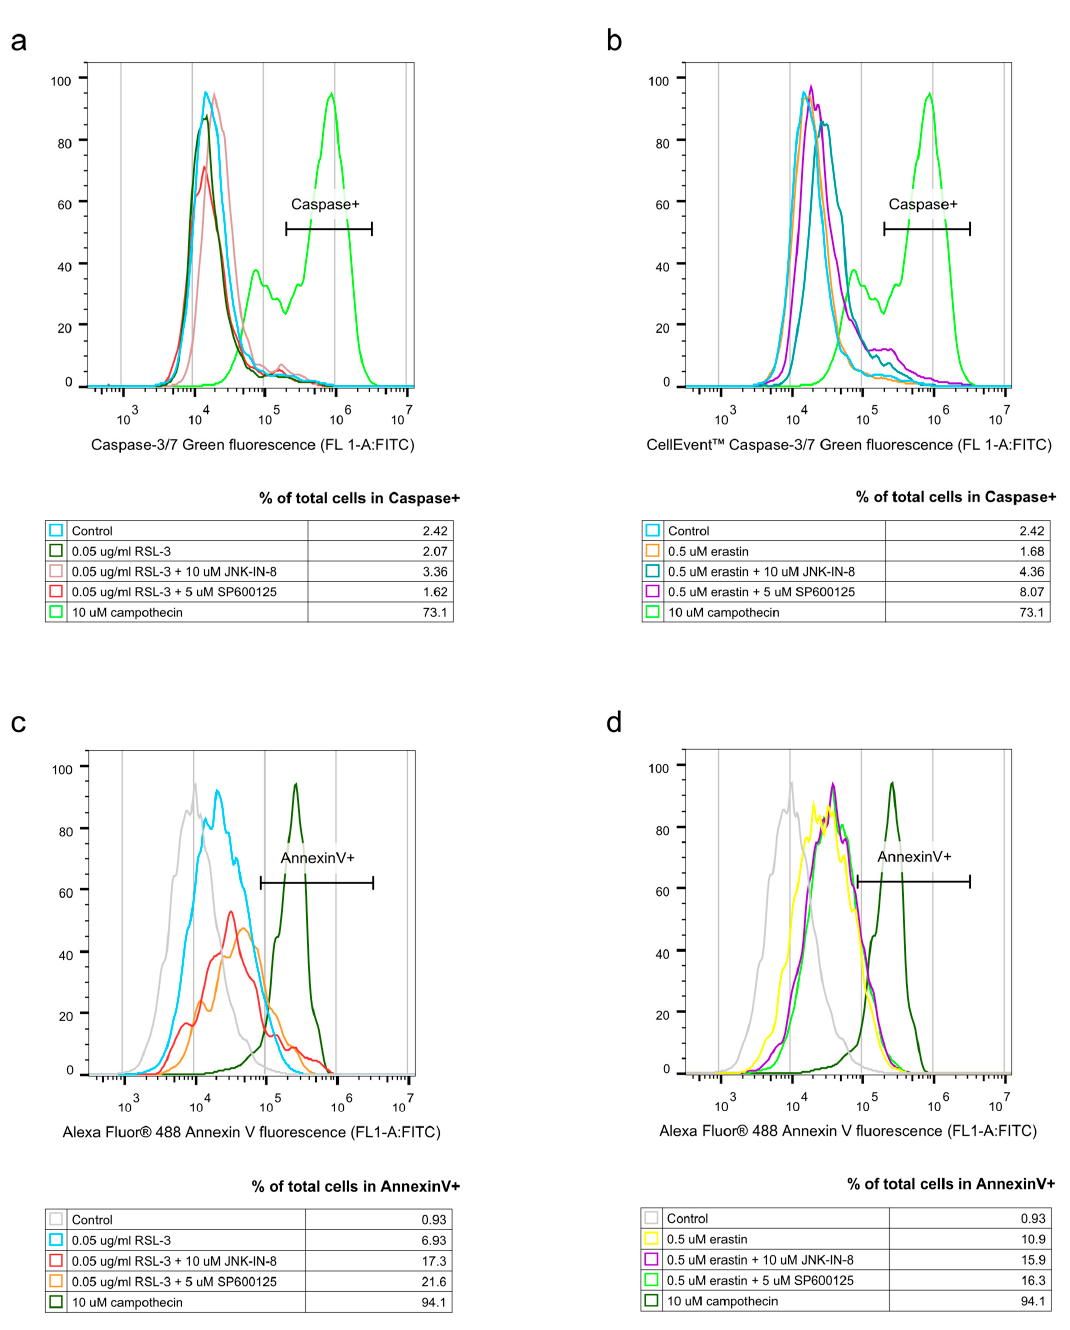
Figure A1. Measurement of apoptosis markers after treatment with ferroptosis inducers and JNK inhibitors. The HT-1080 cells were treated on a 6-well plate for 24 h with the ferroptosis inducing compounds ( a , c ) RSL-3 (0.05 µg/mL) or ( b , d ) erastin (0.5 µM) in the presence or absence of the JNK inhibitors, JNK-IN-8 (10 µM) or SP600125 (5 µM). Cells were prepared, stained, and measured with a flow cytometer as described above ( a , b ) using CellEvent™ Caspase-3/7 Green Detection Reagent for measuring caspase activation and ( c , d ) Annexin V Alexa Fluor 488 conjugate for the measurement of the externalization of phosphatidylserine on the plasma membrane. Control samples were fluorescent-labelled but untreated. One representative experiment is shown. Cell population was gated using FSC-W for singlets and propidium iodide negative staining (living